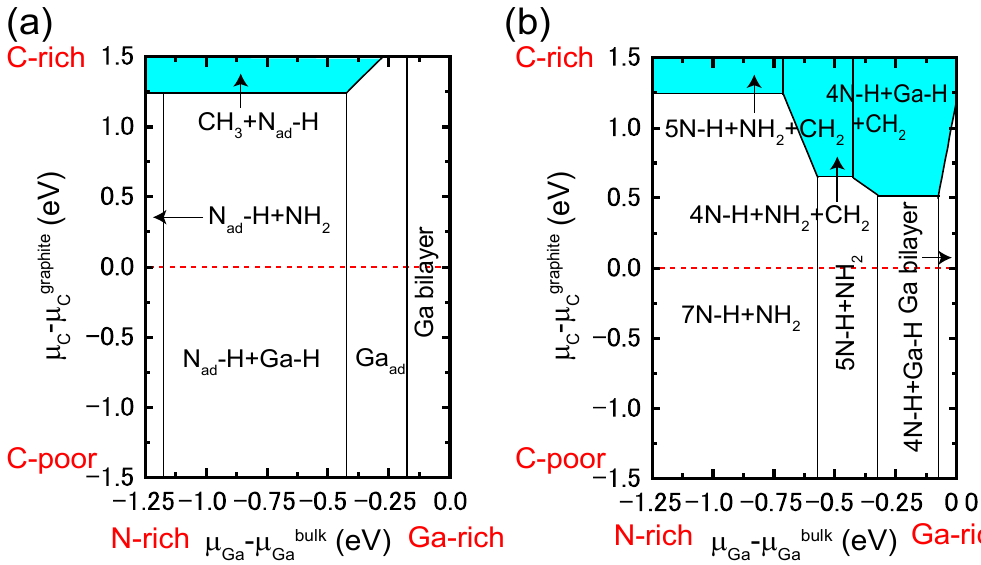
Figure 37. Stable structures of carbon incorporated ( a ) GaN(0001) and ( b ) GaN (cid:4666)11(cid:3364)01(cid:4667) surfaces as a function of Ga chemical potential, μ pressure conditions ( μ H 2 molecule). The stable carbon incorporated surface regions are